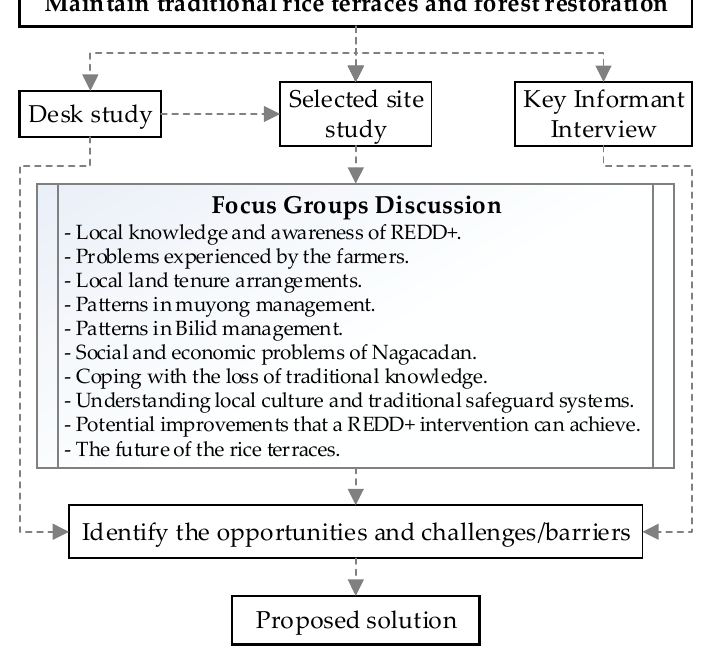
Figure 5. Chart of study progress to maintain traditional rice terraces and forest restoration.